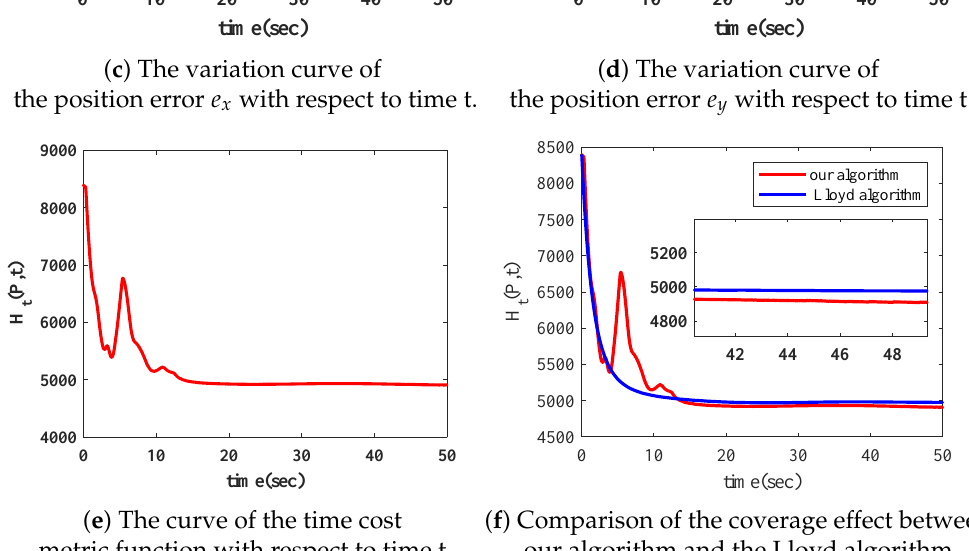
( f ) Comparison of the coverage effect between our algorithm and the Lloyd algorithm. Figure 3. The variation curves of s x , s y , e x and e y of the four robots with respect to time, the varia- tion curves of metric function H t ( P , t ) and the comparison of optimization effects with the classic Lloyd